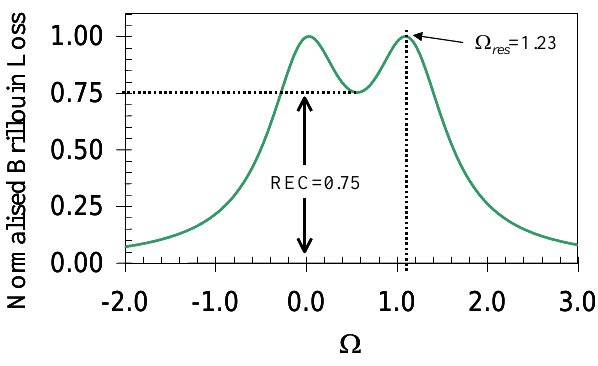
Figure 5. Definition of the REC for simulated Brillouin loss spectrum with the fiber length of 1,000 m, z = 0, Pump = 30 mW, Probe = 5 mW, pulse length = 20 m [31] (Copyright © 2005 IEEE, Reprinted with permission).